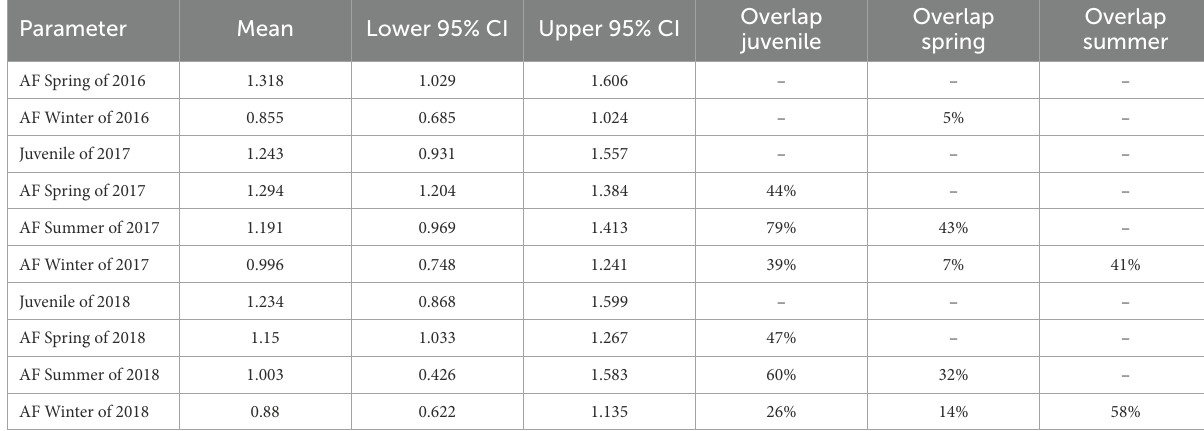
TABLE 3 Results from the ANOVA in a Bayesian hierarchical framework testing the effect of year and seasonal groups (i.e., Spring: March – May, Summer: June – August, Winter: November – February) on the diversity in the diets of desert bighorn sheep at Lone Mountain, Nevada (2016–